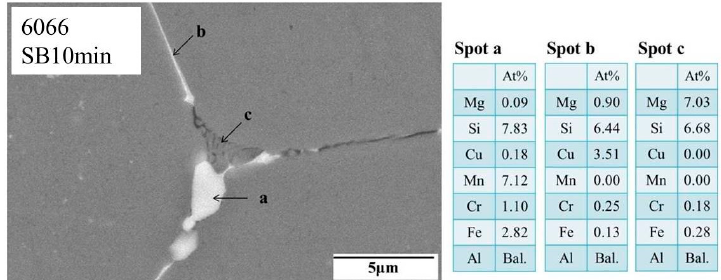
Figure 7. Energy-dispersive X-ray spectroscopy (EDS) analysis of phases at globule boundaries in SIMA-processed 6066 alloy.